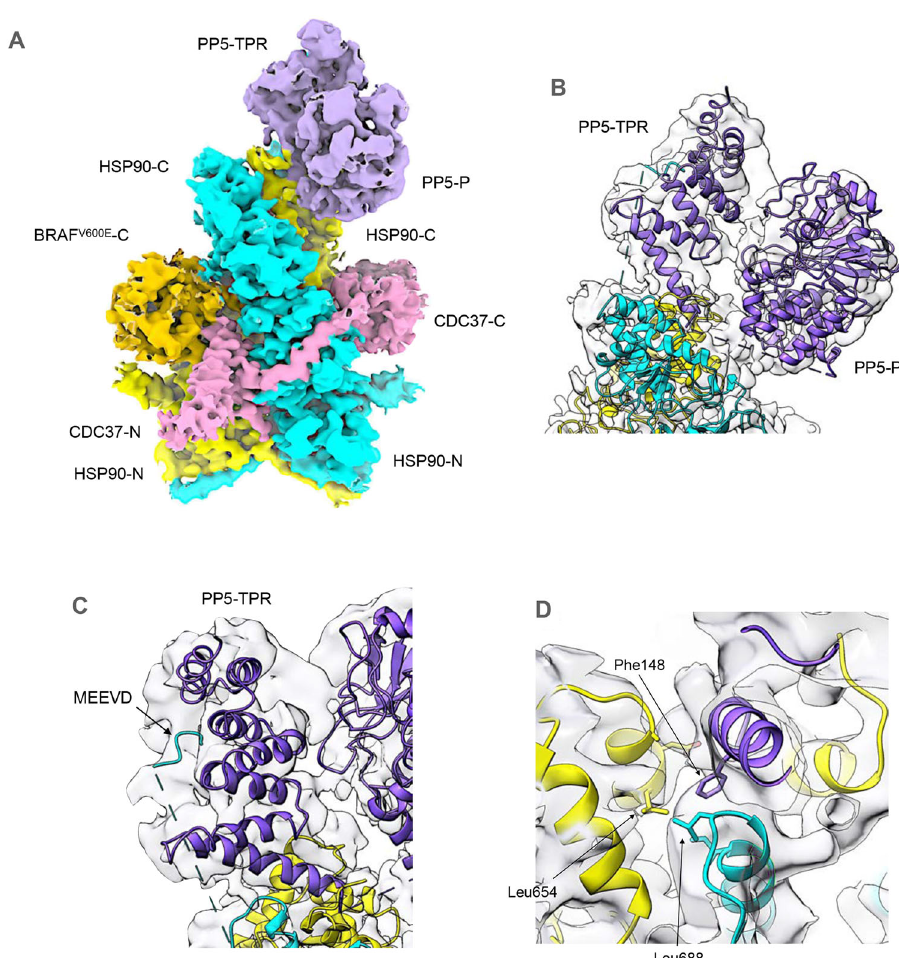
Fig. 2| StructureofHSP90 – CDC37 – BRAF V600E complexwithautoinhibitedPP5. Experimental cryoEM map of HSP90 – CDC37 – BRAF V600E – PP5 complex, surface coloured as Fig. 1, but with the addition of PP5 (purple), bound to the C-terminal end of theHSP90dimer.Theresolutionofthe regionofthe mapcorrespondingto PP5 does not allow ab initio tracing of the polypeptide chain, which has therefore been modelled by rigid-body docking of previously determined crystal structures for the globular regions into the corresponding volume. The fi t of the molecular model was then optimised by real-space re fi nement. A PP5 is bound in the auto- inhibited closed conformation 37 in which the convex face of the TPR domain